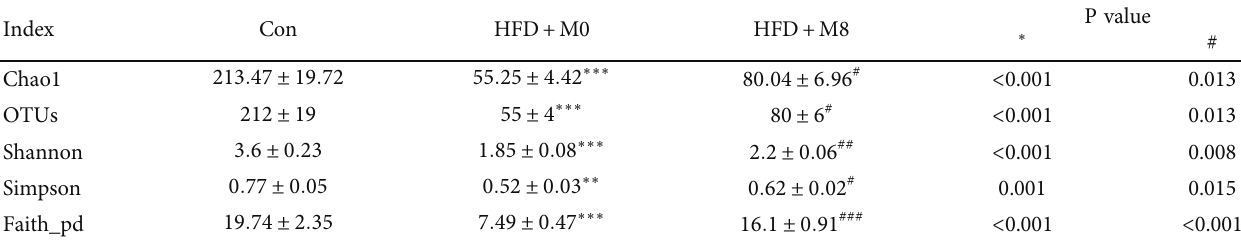
Table 8: E ff ects of high-fat diet supplemented methionine on gut bacterial diversity indices ( n = 3